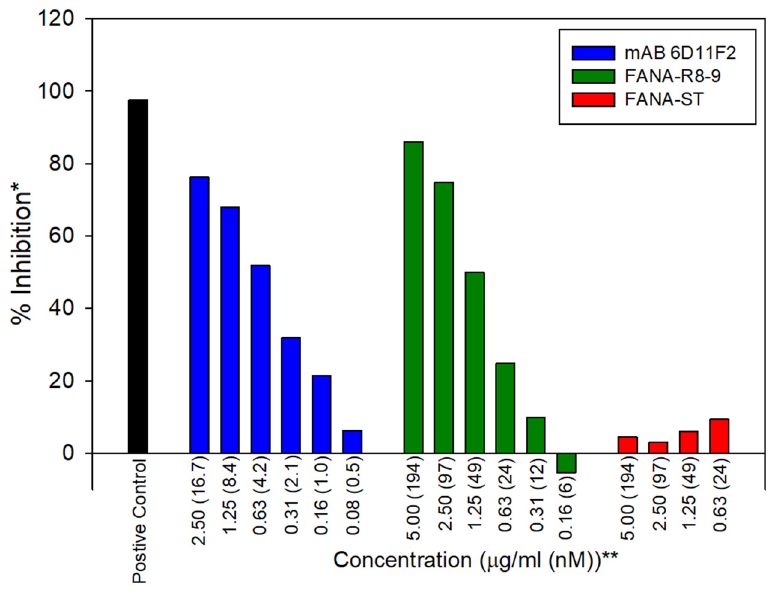
Figure 5. ELISA assay to test the ability of antibodies and aptamers to block ACE2 binding to the RBD domain. Neutralizing RBD antibody (GenScript 6D11F2) was compared with FANA-R8–9 and FANA-ST (starting material) in an ACE2 ELISA assay (GenScript). *Percent inhibition was calculated based on positive and negative controls supplied by the manufacturer. The negative control produced a value of “0” in the assay and is not shown. See Materials and Methods for more details. ** Values are given in both µ g/mL and nM. Note that each antibody contains two binding sites. The experiment was repeated with similar results. See text for more